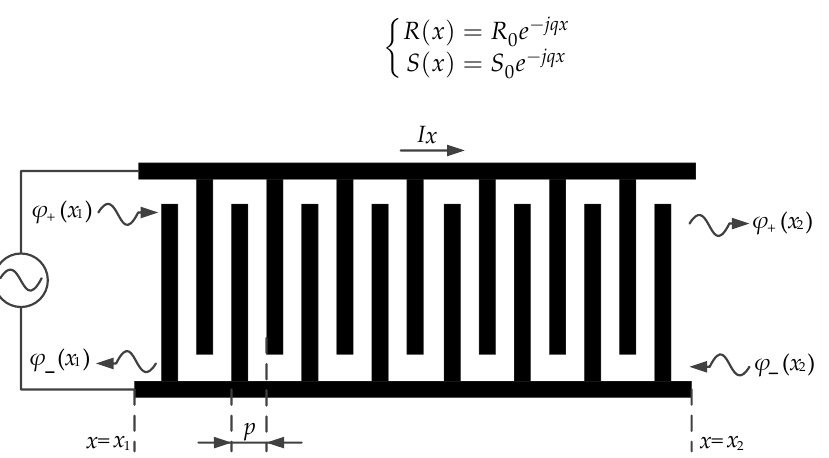
Figure 2. IDT structure model of the phonon piezoelectric device of the NV center.